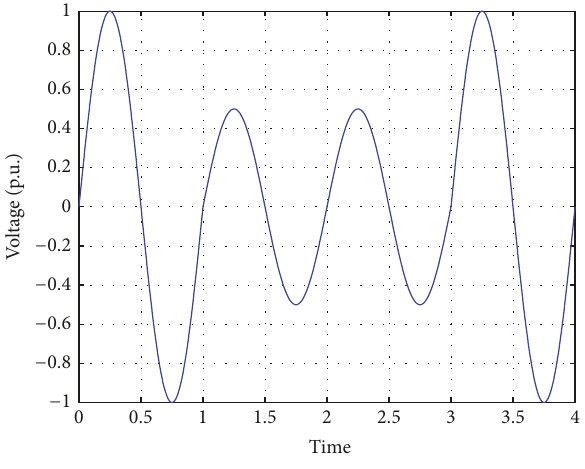
Figure 8: Voltage sag (dip) [12]. Figure 9: Voltage swell